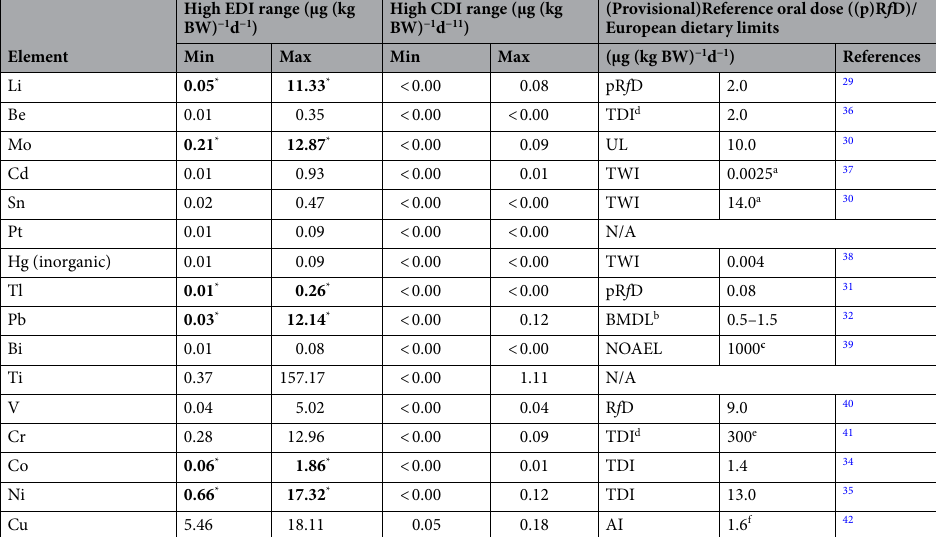
Table 6. Summary of the range of results (minimum to maximum) for short-term Estimated Daily Intake (EDI) and Chronic Daily Intake (CDI) for each metal across all samples ( n = 50) representing the worst-case exposure scenario at a high theoretical ingestion rate (i.e. 200 g day −115 ) of medicinal herbs or preparations and corresponding limits. Calculation of each individual analytical results not shown in table. Element(s) highlighted in bold(*) are in exceedance of accompanying dietary limits. a Tolerable weekly intake (TWI) = mg (kg BW) −1 wk −1 ; b Benchmark dose levels (BMDL’s) for Pb (µg (kg BW) −1 d −1 ): 0.5 (BMDL 01 [Developmental neurotoxicity]), 1.5 (BMDL 01 [blood pressure]) and 0.63 (BMDL 10 [kidneys]) 33 ; c No